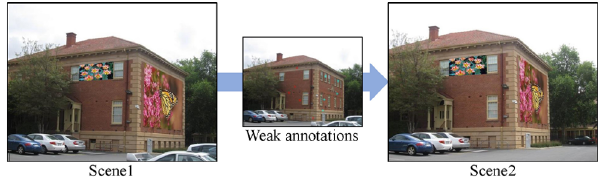
Planar augmented reality application based on multi- homography detection with weak annotations. In scene 1, two synthetic images are photo-realistically placed on two manually specified regions, respectively. To adaptively transform the inserted images when scene 1 changes to scene 2, G2MF-WA requires several weak annotations which can be provided interactively using matched keypoint